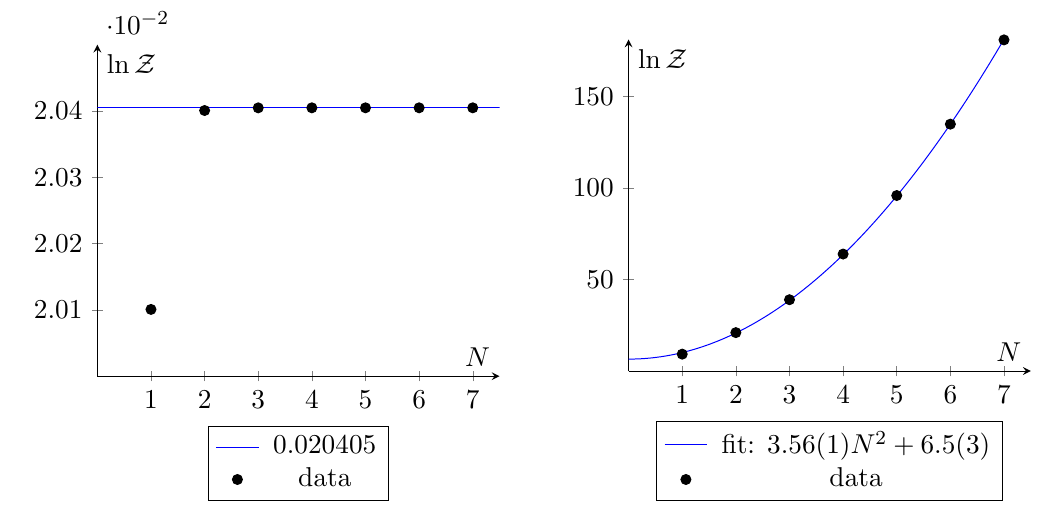
Figure 2 . Plots of the logarithm of the su (2) partition functions for N = 1 ; : : : ; 7 in the low temperature regime (left) with x = 0 : 01 and the high temperature regime (right) with x = 0 : 99. The plot on the left includes a constant line at ln Z su (2) ( x = 0 : 01) (cid:24) 0 : 020405, for comparison. On N =7 the right, we (cid:12)t the data to the function c 2 (cid:1) N 2 + c 0 , with an R 2 -value of 0 : 999951. As evident from the respective plots, the free energy scales as N 0 =N 2 in the low/high temperature regime. On the left, we have set x = 0 : 01 corresponding to T (cid:25) 0 : 217. On the right, we